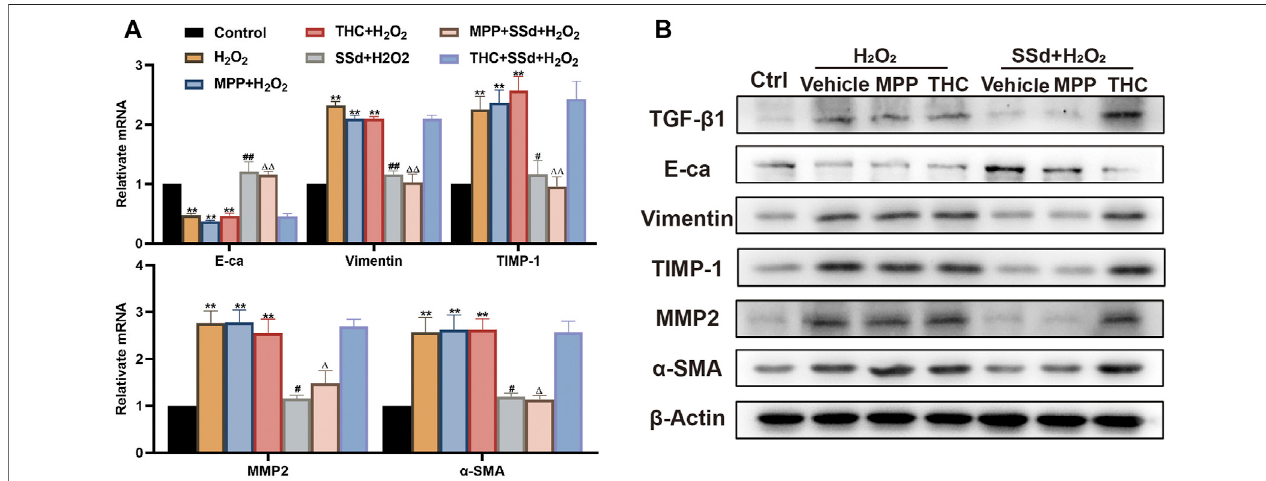
FIGURE 8 | Speci fi c antagonist of ER β , but not ER α , blocked the inhibitory effect of SSd against H 2 O 2 -induced extracellular matrix deposition and EMT in HSCs (A,B) the indicators of extracellular matrix deposition and EMT ( α -SMA, TGF- β 1, TIMP-1, MMP-2, Vimentin, and Ecadherin) expression in HSCs were detected by RT- PCRandWB, n =3.Dataareexpressedinmean±SEM;** p < 0.01,H 2 O 2 ,H 2 O 2 +MPP,andH 2 O 2 +THCgroupversuscontrolgroup; # p < 0.05, ## p < 0.01,SSd+H 2 O 2 group versus